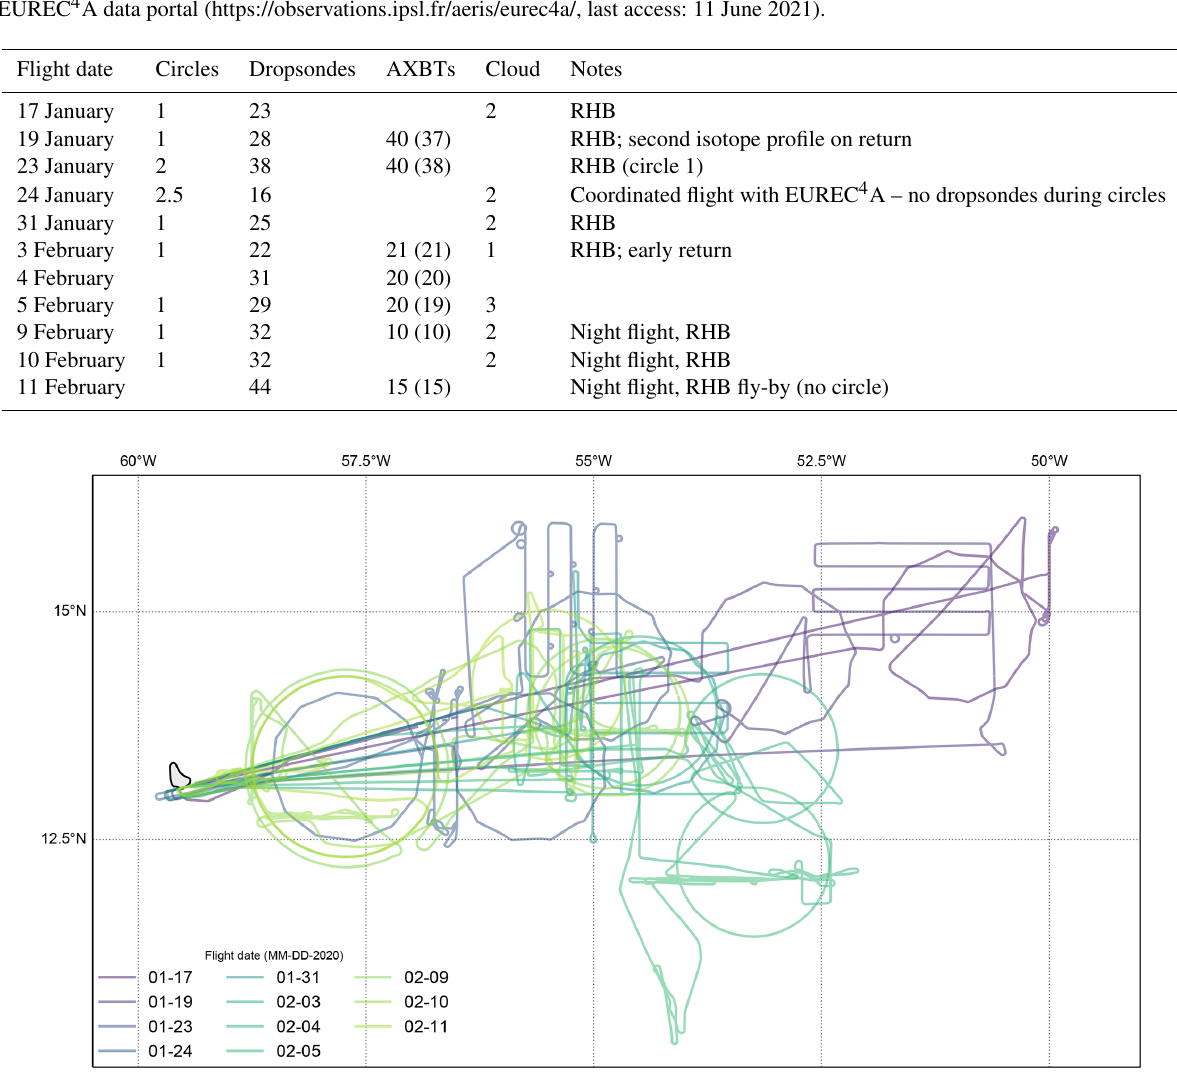
Figure 1. Flight tracks for the 11 flights made by the NOAA P-3 aircraft during ATOMIC on a map with the island of Barbados at left center. Most dropsondes were deployed from regular dodecagons during the first part of the experiment with short turns after each dropsonde providing an off-nadir look at the ocean surface useful for calibrating the W-band radar. A change in pilots midway through the experiment led to dropsondes being deployed from circular flight tracks starting on 31 January. AXBTs were deployed in lawnmower patterns (parallel offset legs) with small loops sometimes employed to lengthen the time between AXBT deployment to allow time for data acquisition given the device’s slow fall speeds. Profiling and especially in situ cloud sampling legs sometimes deviated from straight paths to avoid hazardous weather. The color coding is drawn from a palette spanning the length of the experiment, so that days that are close in time have similar